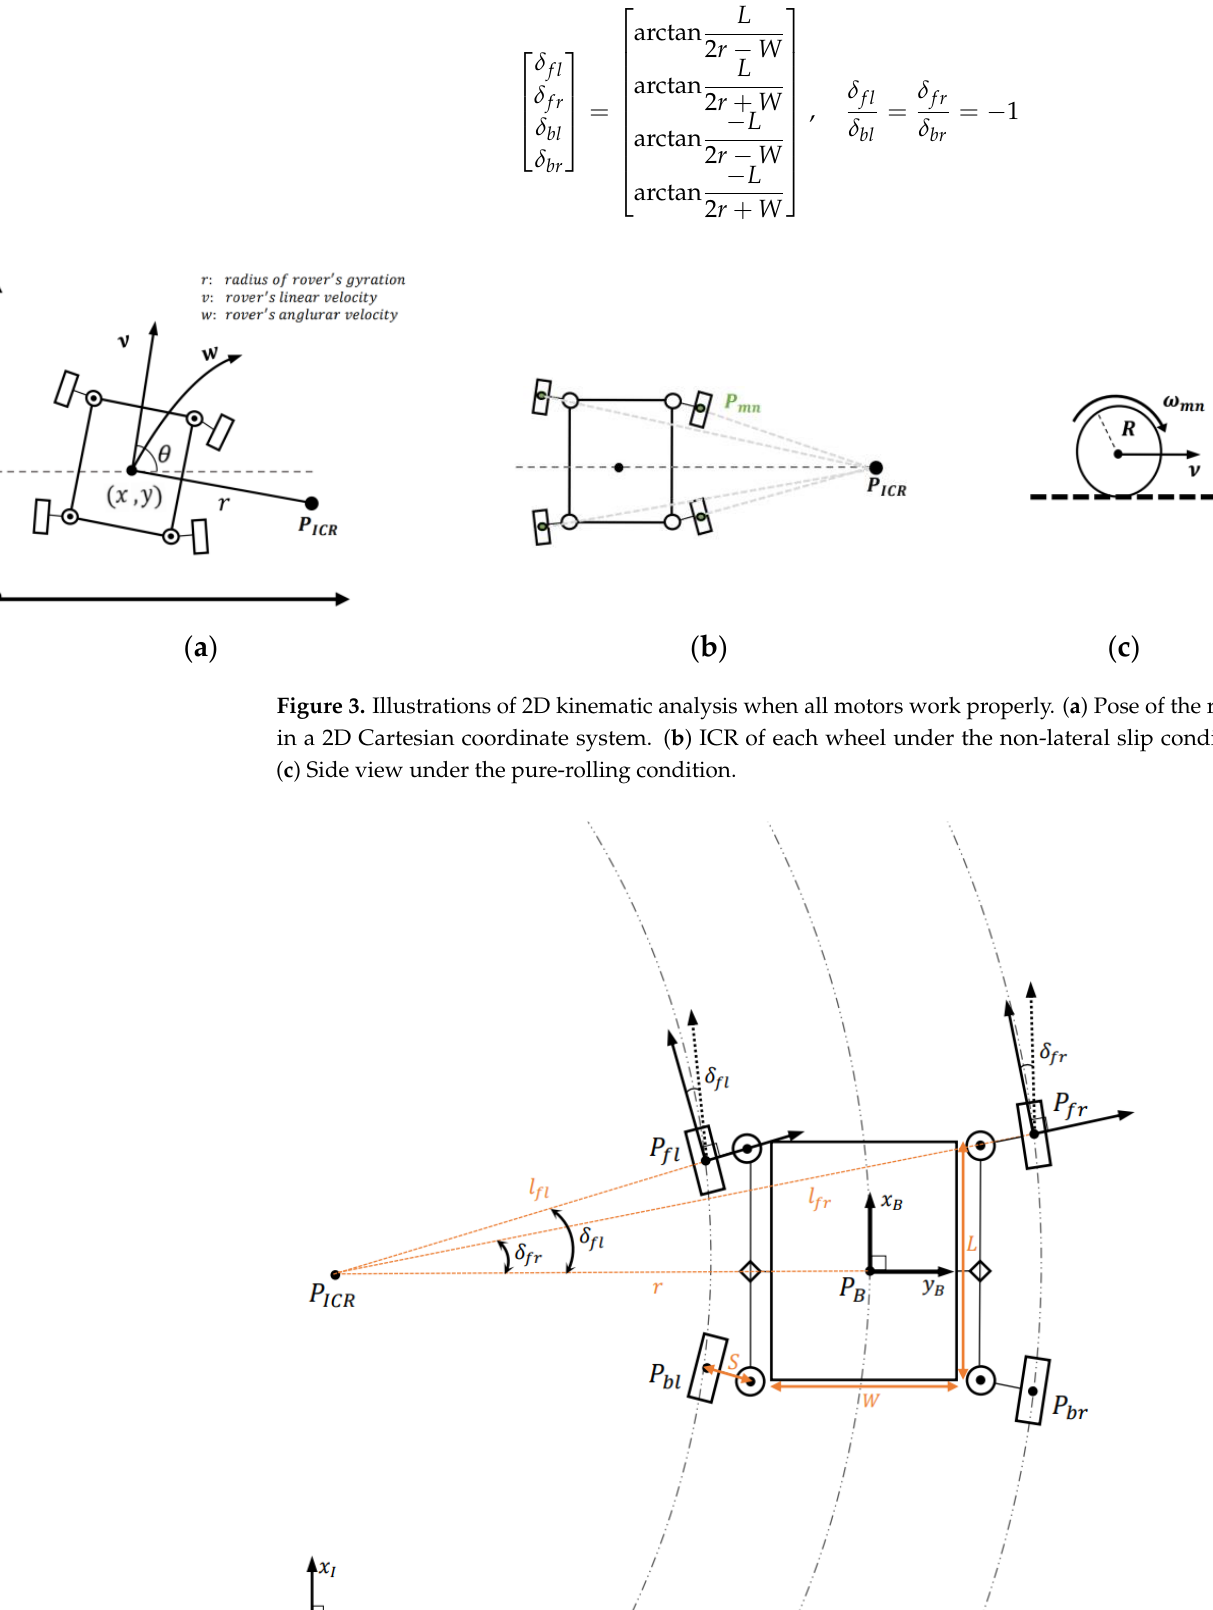
Figure 3. Illustrations of 2D kinematic analysis when all motors work properly. ( a ) Pose of the robot in a 2D Cartesian coordinate system. ( b ) ICR of each wheel under the non-lateral slip condition. ( c ) Side view under the pure-rolling condition.